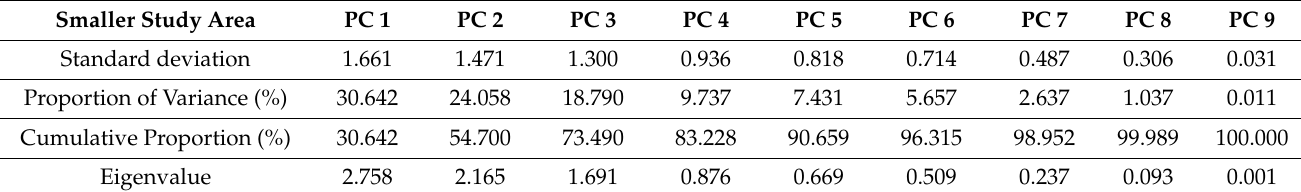
Table 6. Eigenvalues for the smaller study area.